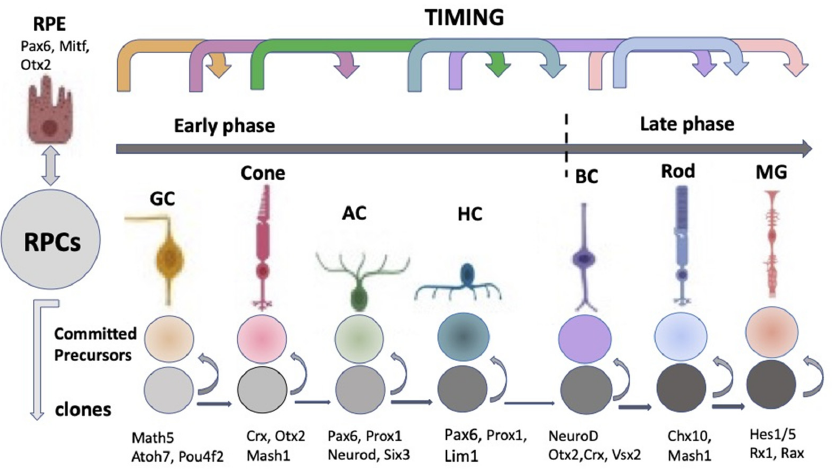
Figure 3. Schematic representation of the classical competence model for eye development. Accord- ing to the model, retinal progenitor cells progress through the competence windows during which a specific retinal cell type is generated. RPCs—retinal progenitor cells; RPE—retinal pigment epi- thelium; GC—ganglion cell; AC—amacrine cells; HC—horizontal cells; BC—bipolar cells; MG— Müller glial cell. At the top: the sequential manner of a retinal cell’s differentiation. It has early and late phases. The represented sequence is general for vertebrates, although conditional, since the stages overlap with each other and have species-specific features. Key transcription factors respon- sible for retinal cell type specification are indicated at the bottom.